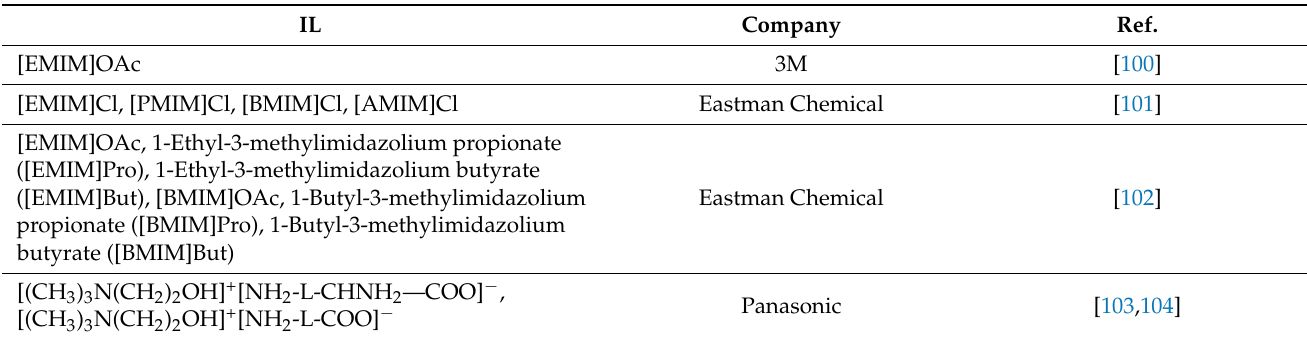
Table 3. Ionic liquids used in industries to process cellulosic materials. IL Company Ref.